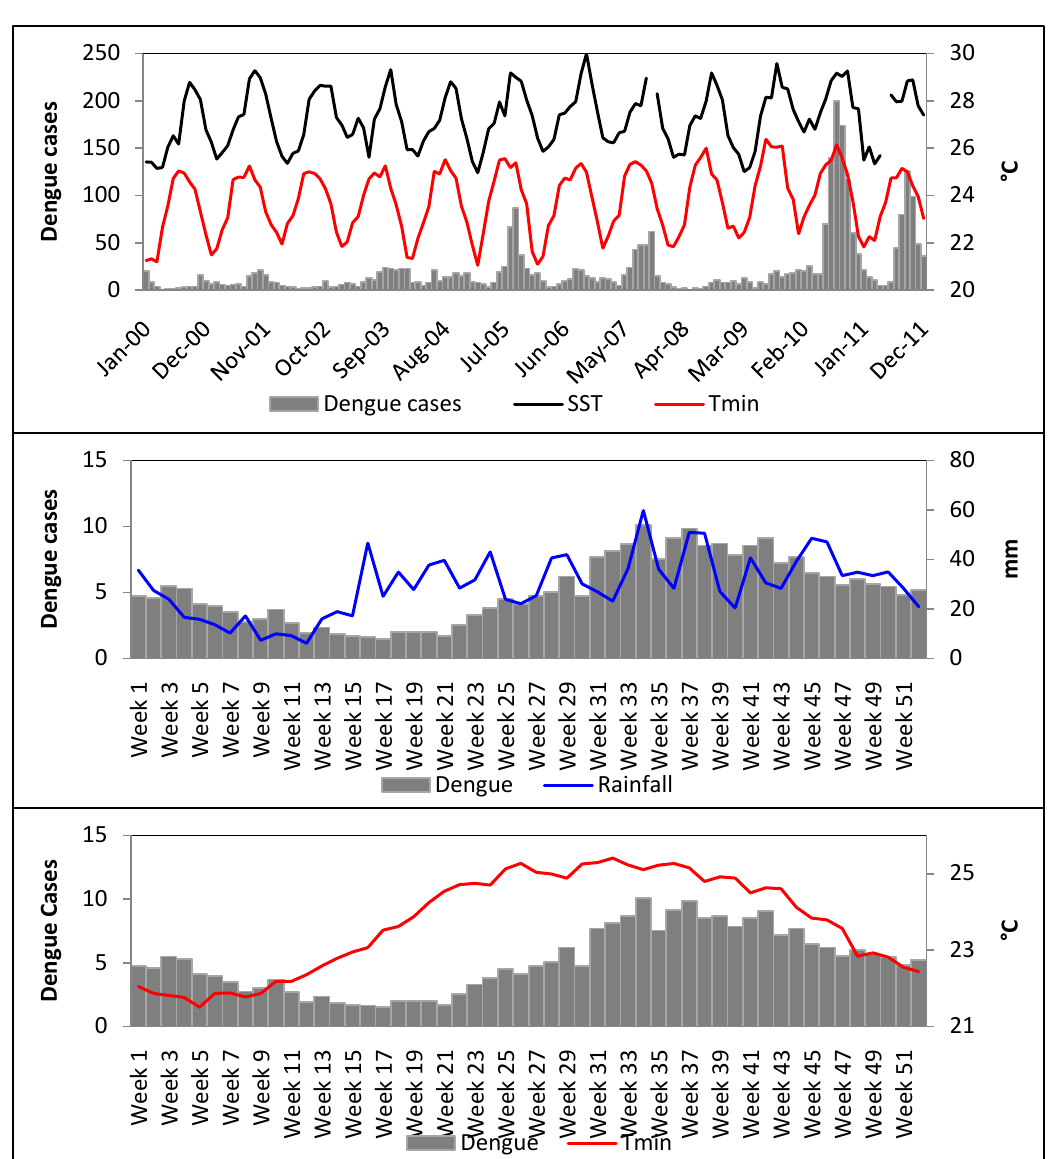
Figure 6. Upper: Monthly sea surface temperature (SST), minimum air surface temperature (Tmin) and monthly dengue cases (2000–2011). Middle: Weekly rainfall and dengue. Lower: Minimum air surface temperature and weekly dengue